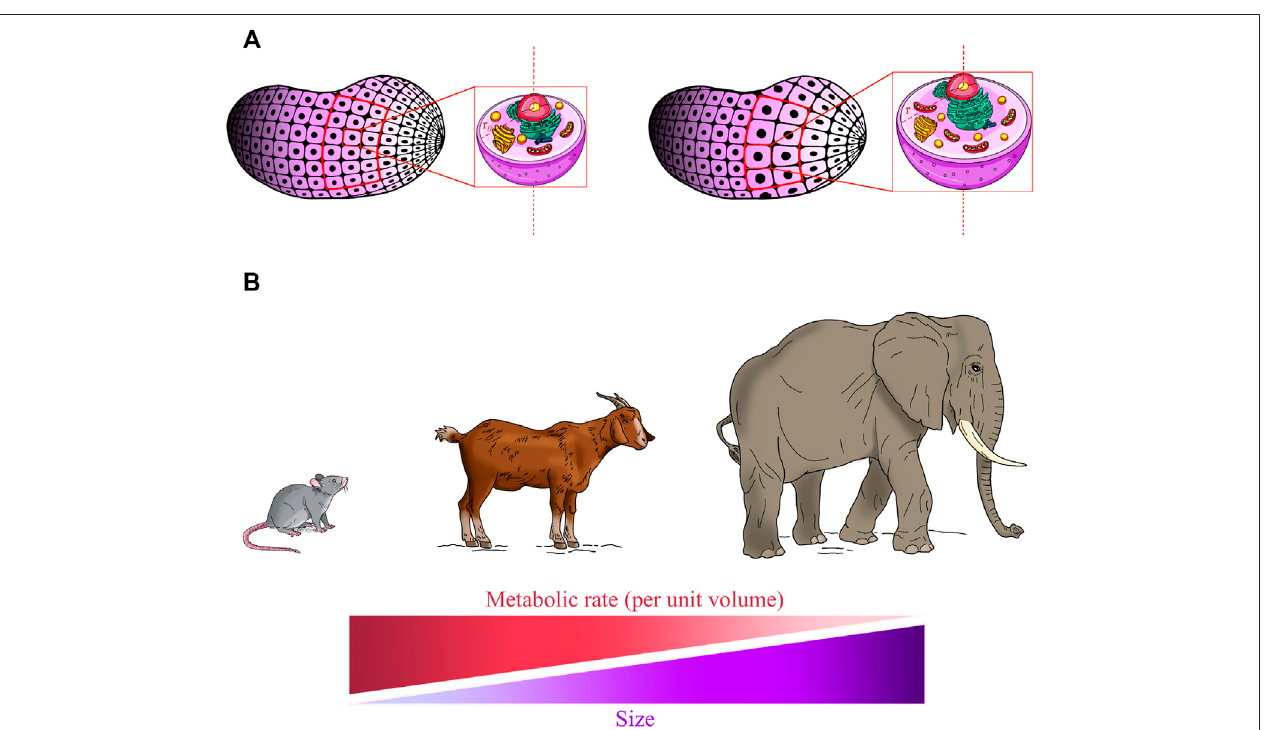
FIGURE1| Living system ’ ssizeaffectshomeostaticbalanceandmetabolicrate. (A) Anideal conditioninwhich anorgan sectionconsistsof “ n ” identicalspherical cells withanaverageradius “ r 0 ” (leftpanel, red frame). Inresponsetoinjury, thesurviving cellsgrow toradius “ r ” (rightpanel, red frame)tocompensate fortissue loss.As thecellgrowsbigger,thevolumeincreasesmorerapidly(r 3 )thandoesthesurfacearea(r 2 ),andsotherelativeamountofsurfaceareaavailabletopassmaterialstoaunit volumeofthe celldecreases. Asthe tissue section remains constant,the total membranesurface ofthe cells isreduced and thisresults in the decreased ef fi ciency of the tissue in preserving homeostasis. Moreover, intracellular transport distances and diffusion times of oxygen and nutrients are increased and the metabolic rate decreased, negatively affecting overall cell ef fi ciency in conserving cellular homeostatic conditions. (B) Allometric laws are among the most fundamental features of life anditisbelievedthattheycanbeappliedtoallsizescales.Allometricscalingofthemetabolismpredictsthatthemetabolicratepermassunitdeclineswiththeincreasein size in living